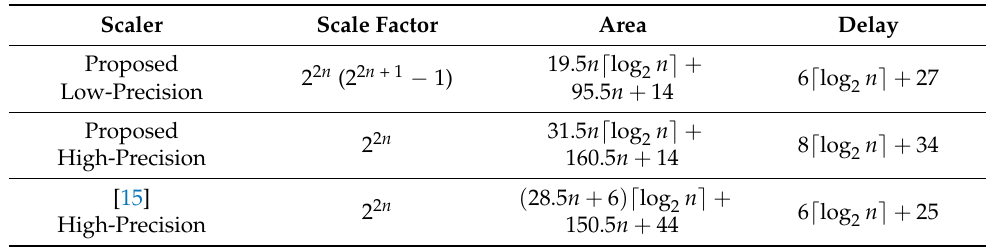
Table 3. The total area and delay estimations for the RNS scalers based on the four-moduli set {2 2 n + 1 − 1, 2 2 n , 2 n + 1, 2 n −